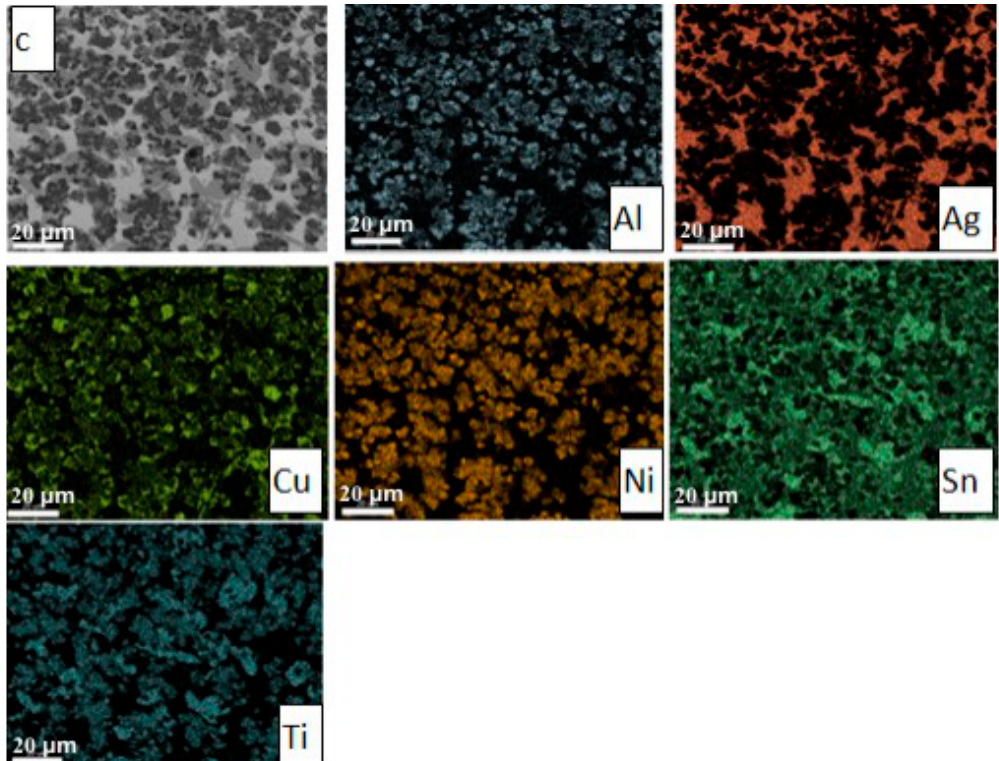
Figure 4. SEM analysis for the equimolar AlAgCuNiSnTi alloy. Electron microscopy image of selected area of the alloys and the spectrum distribution of the alloying elements in the sample: ( a ) as cast specimen obtained by melting in electric arc; ( b ) strip sample; ( c ) alloy homogenized at 800 °C.